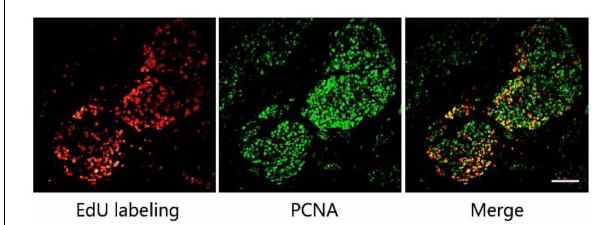
FIGURE 2 | The combination of EdU labeling and immunofluorescence of PCNA. Red fluorescence shows the labeling of EdU with Apollo R (cid:13) 567-N 3 and green fluorescence represents the immunofluorescence of PCNA with FITC-Conjugated Mouse anti-Goat IgG H&L. The images of EdU labeling and PCNA immunofluorescence were superimposed. Scale bar indicates 2 mm.